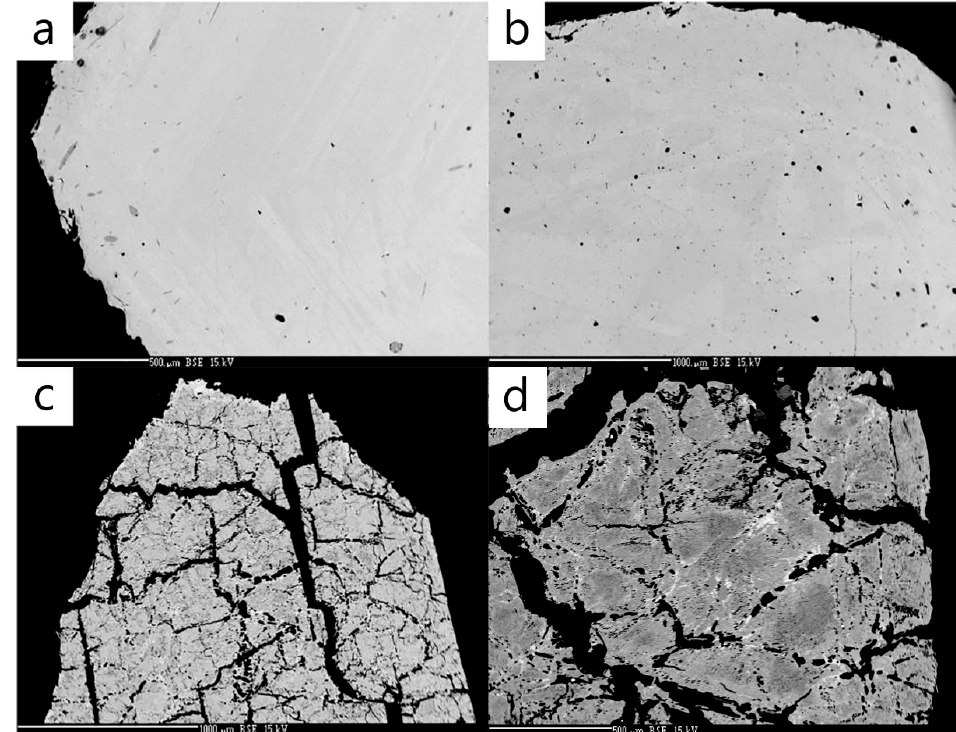
Figure 2. BSE images of heat-treated clinozoisite: ( a ) CP-0; ( b ) CP-9; ( c ) CP-10; ( d ) CP-11. The untreated natural sample ( a ) and sample treated at 900 °C ( b ) displayed only the weak chemical zoning caused by small variations in Al and Fe 3+ content; as in previous samples, heating over 1000 °C led to the formation of breakdown products firstly as a homogeneous mass ( c ), whereas, at 1100 °C, domains with slightly different composition were formed ( d ). and dehydration with a visible increase in size with rising temperature. This phenomenon